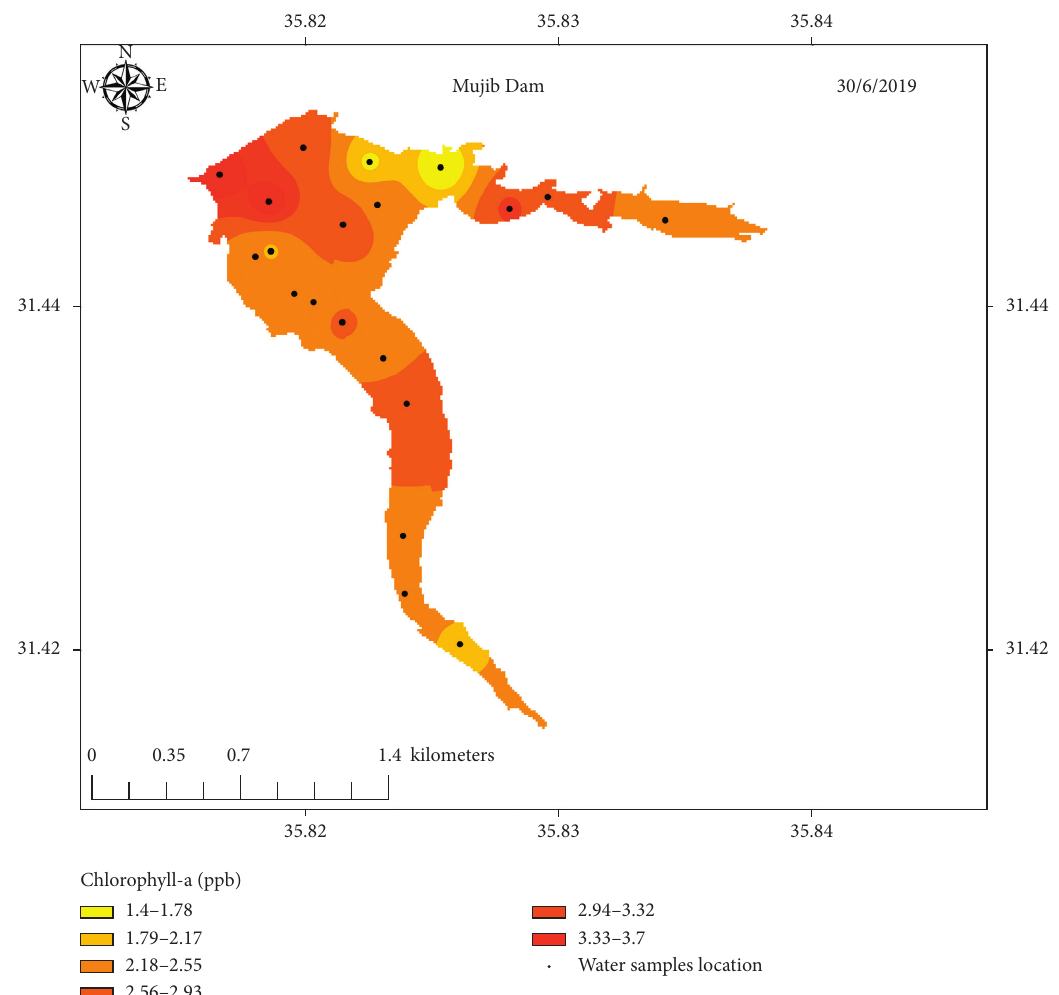
Figure 6: Concentration distribution of Chl-a through Mujib Dam’s